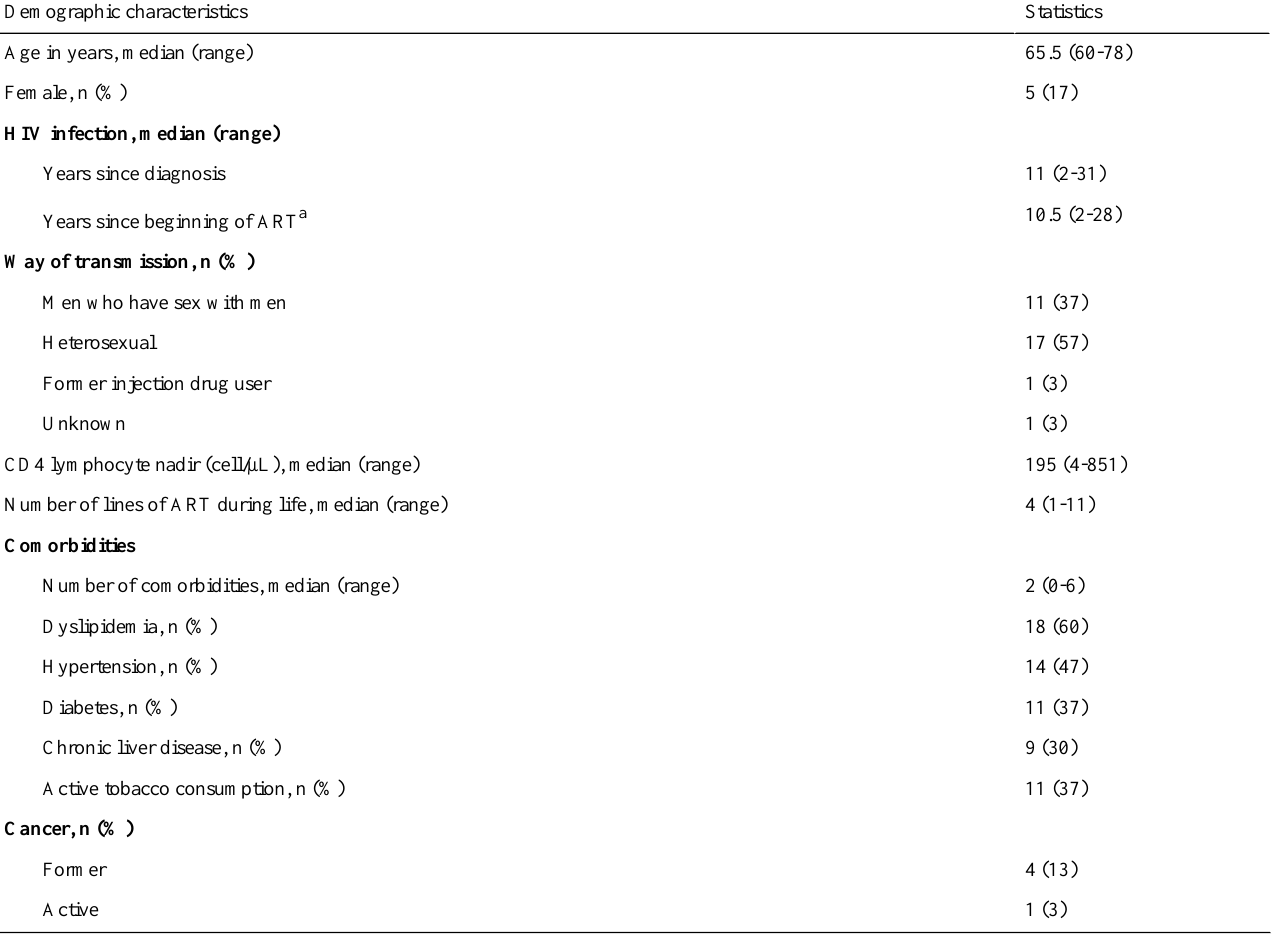
Table 1. Baseline characteristics of the patients